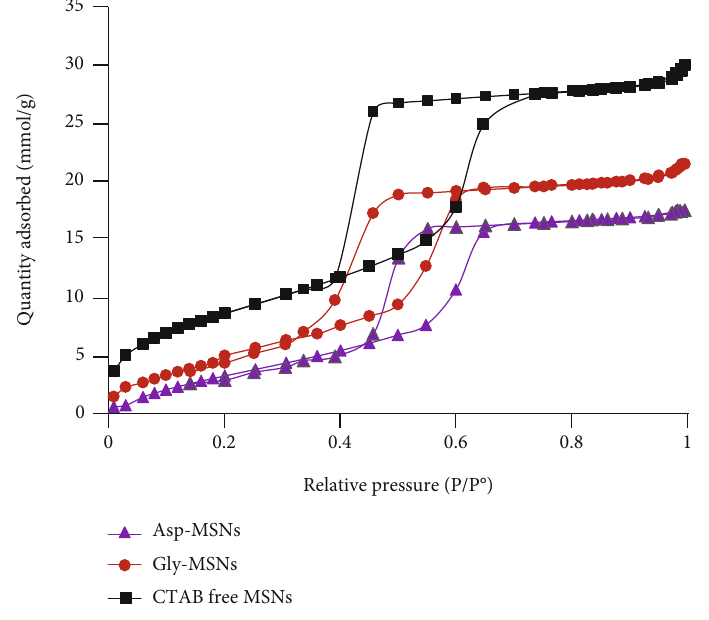
Figure 3: The isotherm obtained for CTAB free MSNs, Gly-MSNs, and Asp-MSNs. Table 1: Comparison of the surface area, pore volume, and pore size of CTAB free MSNs, Gly-MSNs, and